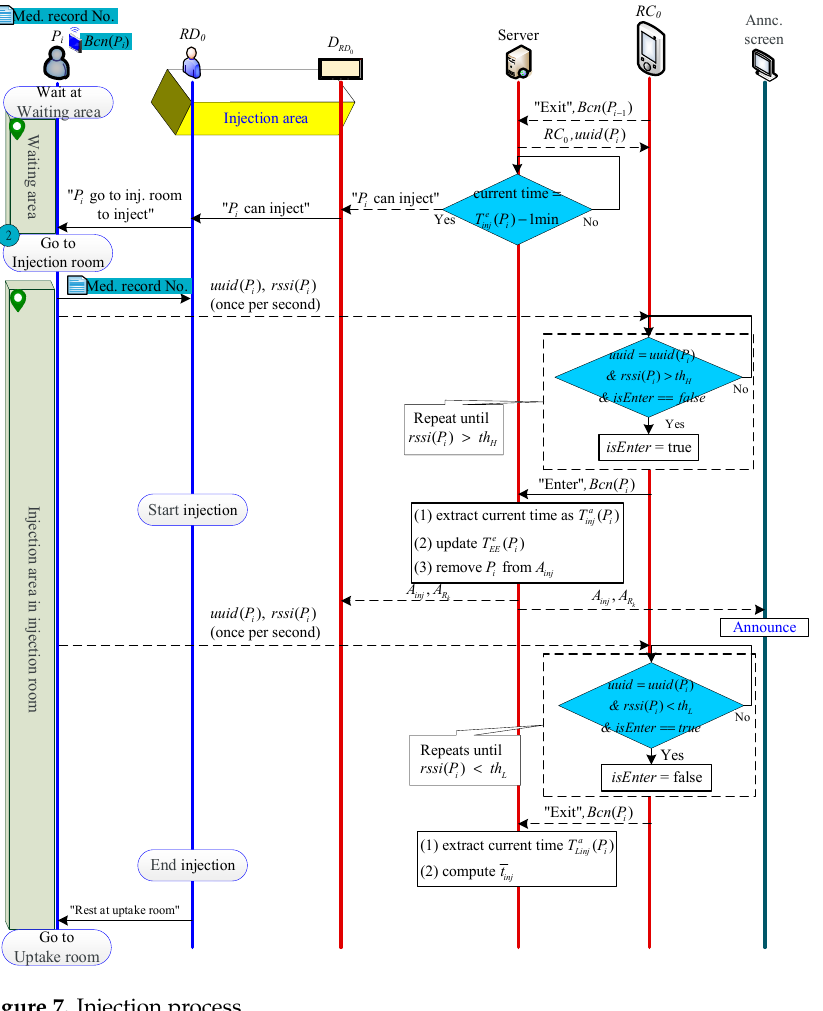
Figure 7. Injection process.